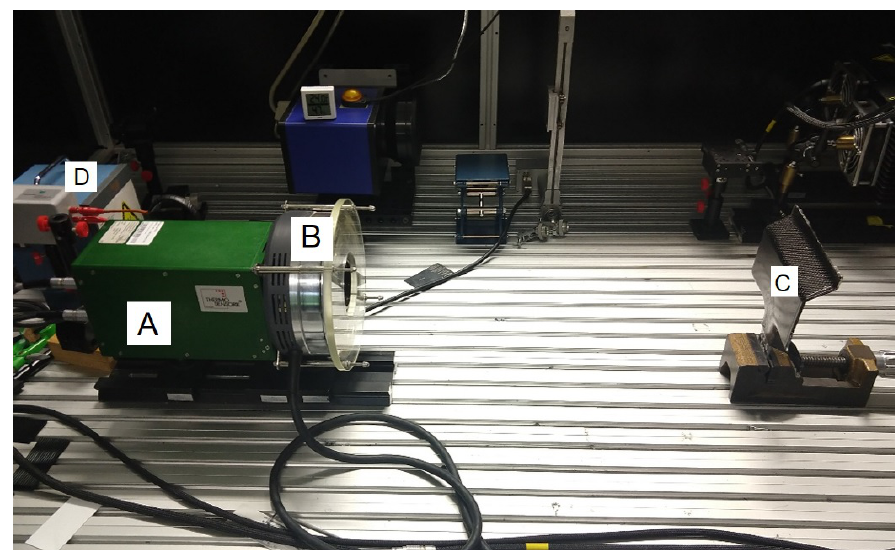
Figure 4. PT set-up used during the experiments. ( A ) IR camera, ( B ) flash (heat source), ( C ) inspected sample, ( D ) black